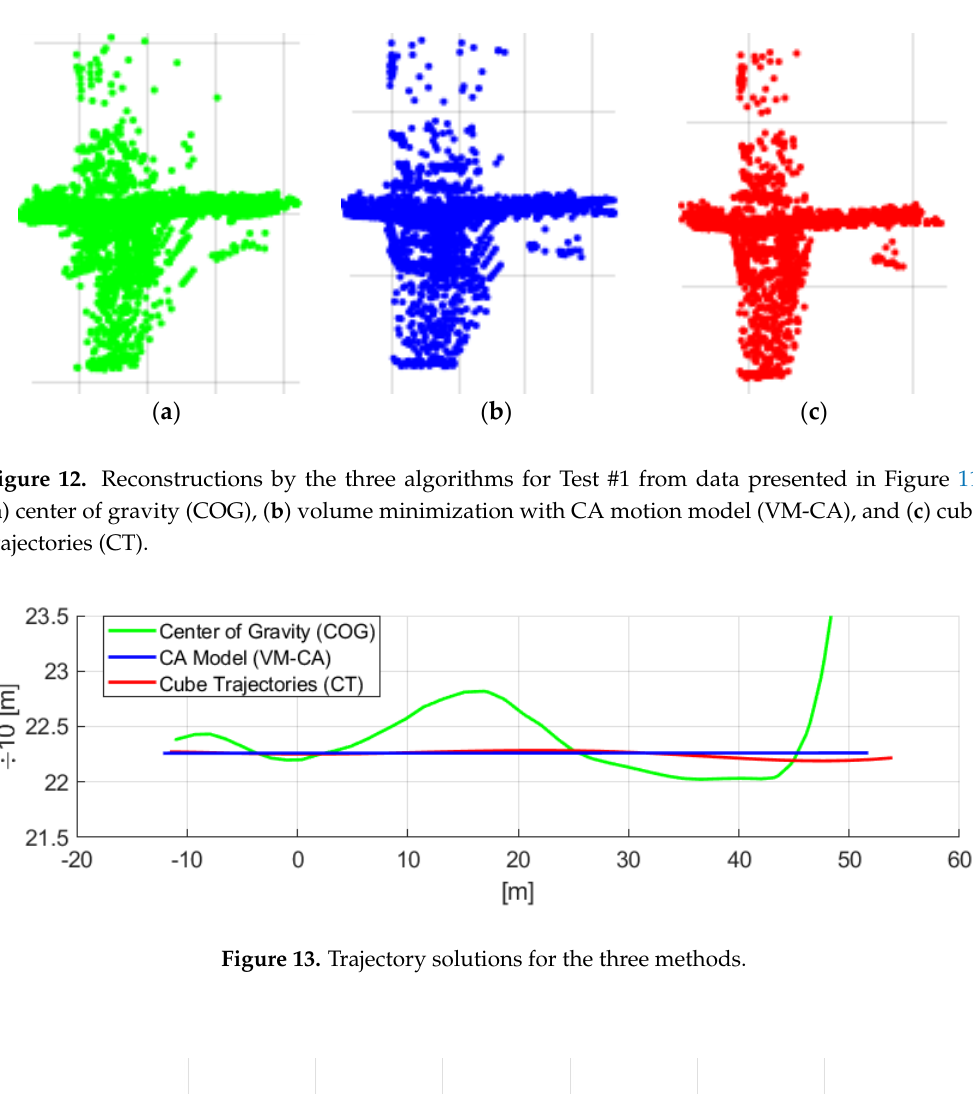
Figure 14. Reconstruction from sparse point clouds (average point density is 36/scans or 7.2 points/scan/sensor), using the CT algorithm for a landing Cessna airplane during Test #2: the captured airplane points are shown in green, the reconstruction is in blue.